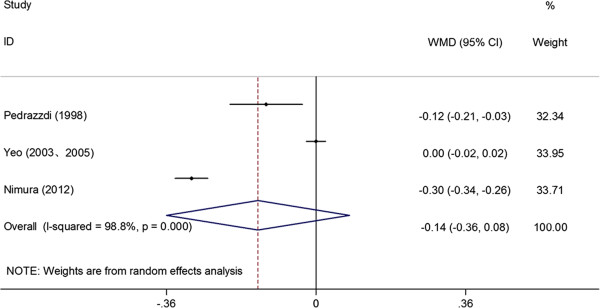
Forest plot for the amount of blood transfusions between the pancreatoduodenectomy with extended lymphadenectomy (PD/ELND) group and the standard pancreatoduodenectomy PD group. The size of the black box corresponding to each study is proportional to the sample size, and the horizontal line shows the corresponding 95% CI of the relative risk (RR) displayed on the right.